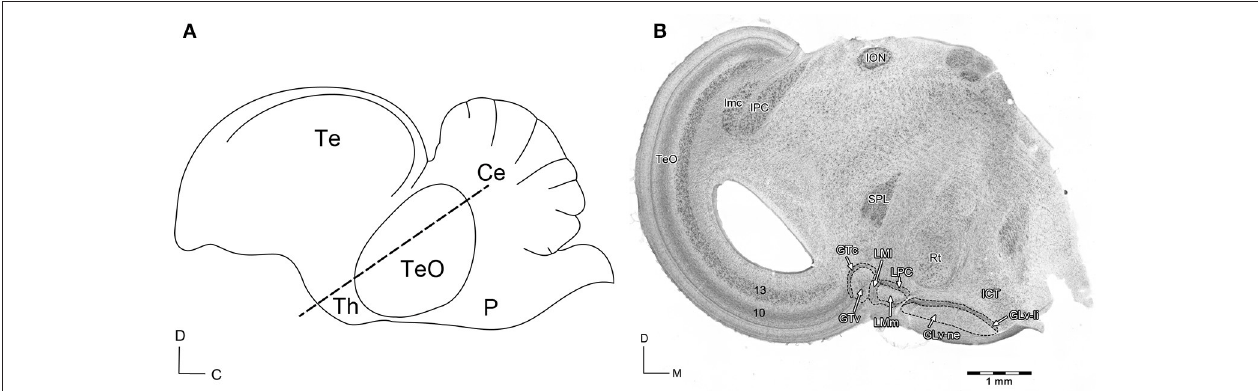
FIGURE 1 | (A) Schematic view of the sagittal Gallus gallus brain. The dashed line indicates the site of the section in (B) . D, dorsal; C, caudal. (B) Giemsa staining of a 60 µ m section that shows the diencephalic nuclei griseum tectale (GTv, GTc), n. lentiformis mesencephali pars lateralis (LMl) and pars medialis (LMm), n. laminaris precommissuralis (LPC), n. geniculatus lateralis pars ventralis-lamina interna (GLv-li) and -neuropil (GLv-ne), and n. intercalatus thalami (ICT). D, dorsal; M, medial. Modified with permission from Vega-Zuniga et al.